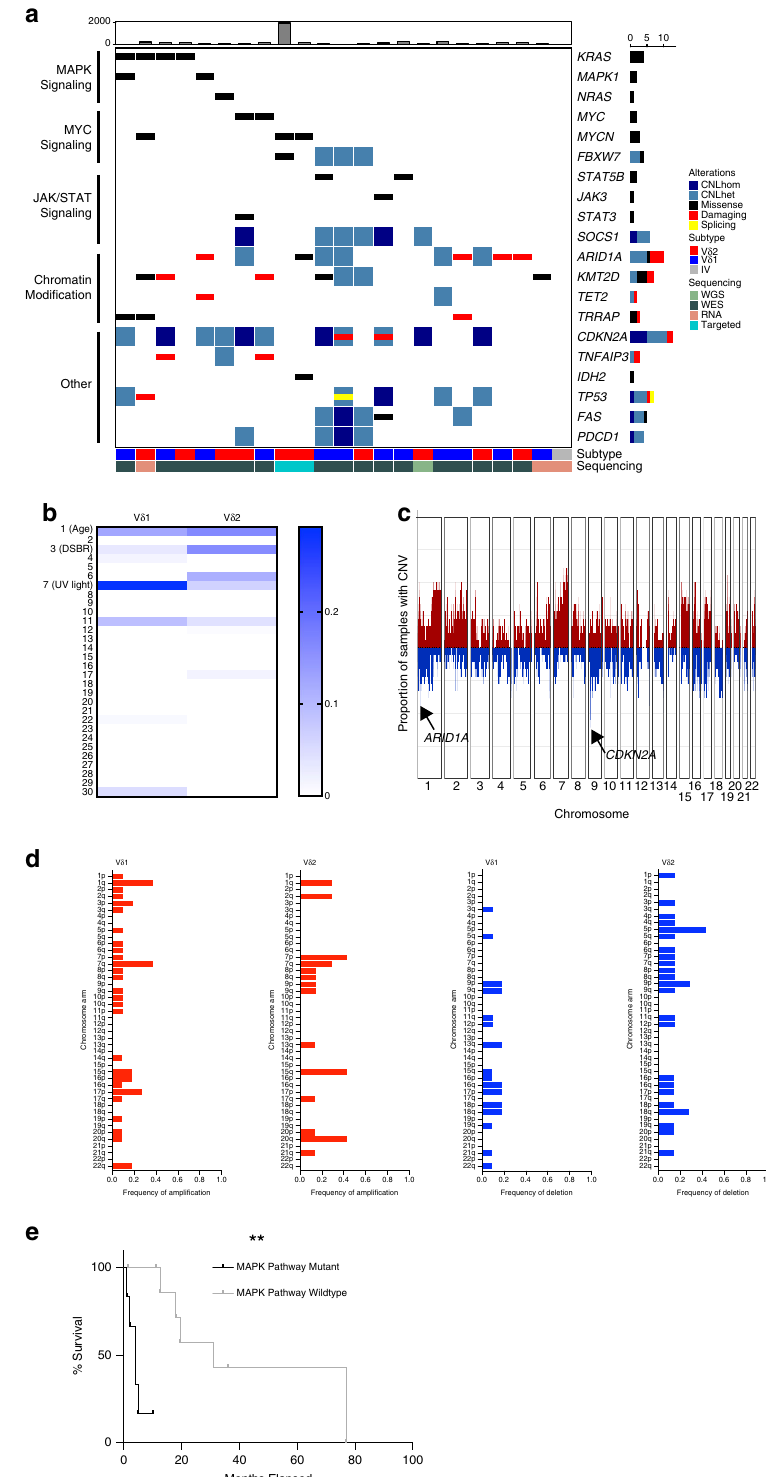
Fig. 5 The genomic landscape of CGDTL. a Putative driver mutations in CGDTL. Rows represent genes, and each column corresponds to a CGDTL sample. Top bar plot indicates number of non-synonymous mutations detected in each sample, and bar plot on the right indicates total number of mutations in each putative driver gene. CNLhom and CNLhet; homozygous and heterozygous copy number loss, respectively. b Median contribution of COSMIC mutational signatures in CGDTL subtypes, V δ 1 n = 11, V δ 2 n = 7. DSBR double-strand break repair defect. c Frequency of copy number alterations. Driver genes within signi fi cant GISTIC peaks are listed. d Frequencies of arm level events in CGDTL subtypes. e Kaplan – Meier curve depicting percent survival with ( n = 6) or without ( n = 9) recurrent hotspot mutations in MAPK pathway genes ( KRAS , MAPK1 , and NRAS ). ** Indicates P value < 0.005, log-rank